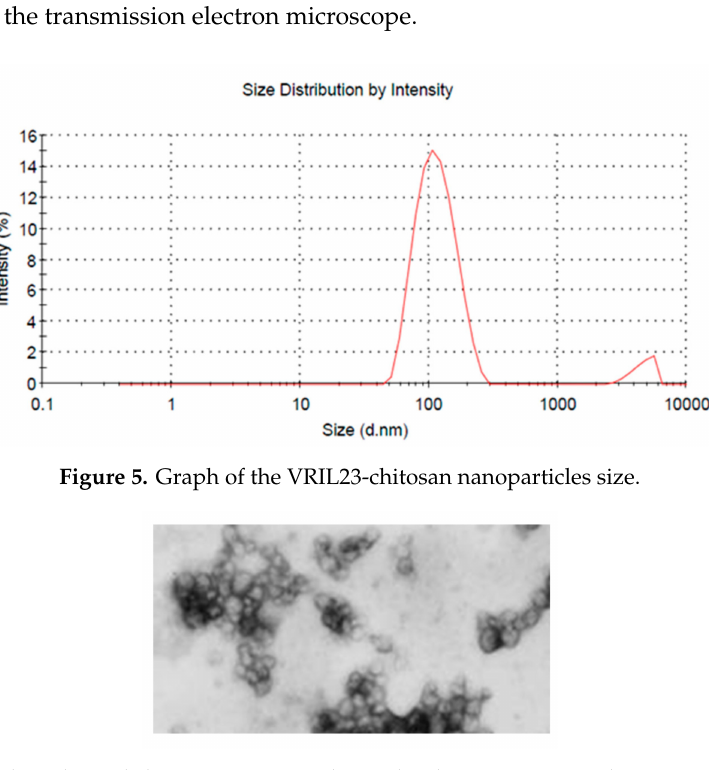
Figure 6. The spherical chitosan nanoparticles under the transmission electron microscope.